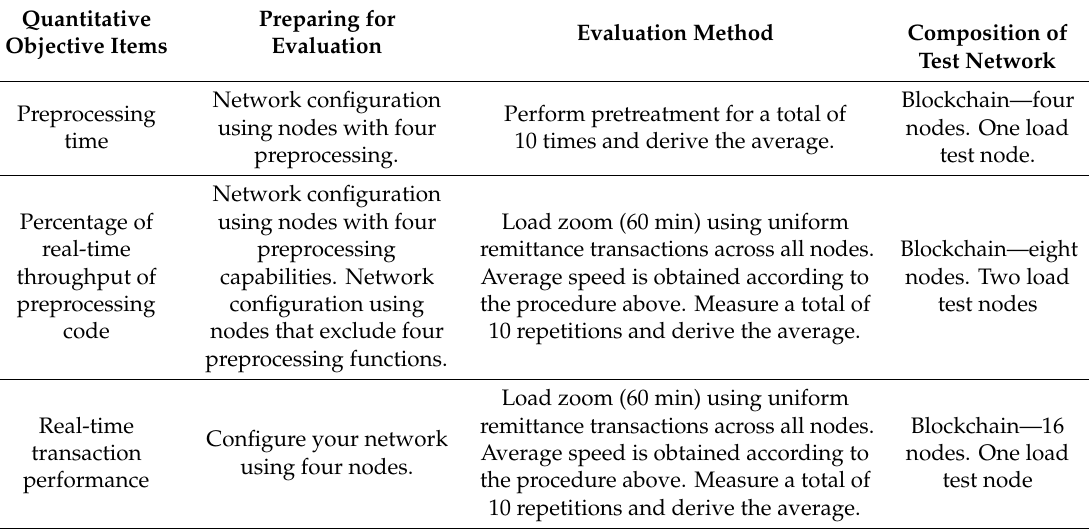
Table 2. Performance measurement o ff